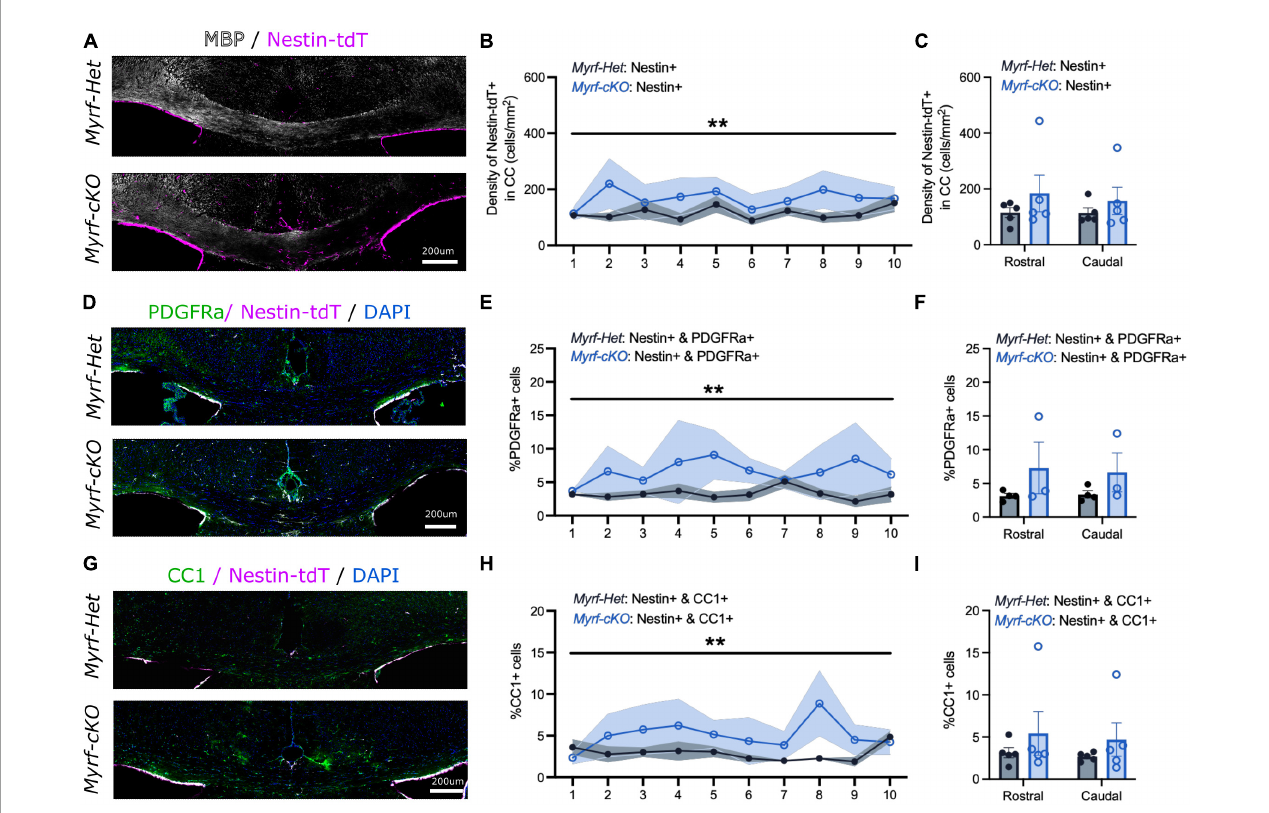
FIGURE4 The contribution of neural stem cell-derived oligodendrocytes (OLs) to remyelination remains elevated at 4 weeks of recovery when parenchymal oligodendrocyte progenitor cell differentiation is blocked. (A) Representative images of Myrf-Het;Nestin-tdT and Myrf-cKO;Nestin-tdT coronal brain sections immunostained for MBP (in white) and Nestin-tdT (magenta) after 4-week recovery (Cup6w + 4w). (B) Quantification of the densities of Nestin-tdT+ cells within the CC of Myrf-Het;Nestin-tdT and Myrf-cKO;Nestin-tdT coronal sections ( n = 5, lines and shading represent mean ± sem, ** p < 0.01, Two-way ANOVA). (C) Average densities of Nestin-tdT+ cells within the CC of Myrf-Het;Nestin-tdT and Myrf-cKO;Nestin-tdT rostral (sections 1–5) and caudal (sections 6–10) sections ( n = 5, error bars = sem, Two-way ANOVA). (D) Representative images of Myrf-Het;Nestin-tdT and Myrf-cKO;Nestin-tdT coronal brain sections immunostained for PDGFRa (in green) and Nestin-tdT (magenta) after 4-week recovery (Cup6w + 4w). (E) Quantification of the percentages of PDGFRa+ cells that were also Nestin-tdT+ in Myrf-Het;Nestin-tdT and Myrf-cKO;Nestin-tdT coronal sections ( n = 3–4, lines and shading represent mean ± sem, ** p < 0.01, Two-way ANOVA). (F) Average percentages of PDGFRa+ cells that were also Nestin-tdT+ in Myrf-Het;Nestin-tdT and Myrf-cKO;Nestin-tdT rostral (sections 1–5) and caudal (sections 6–10) sections ( n = 3–4, error bars = sem, Two-way ANOVA). (G) Representative images of Myrf-Het;Nestin-tdT and Myrf-cKO;Nestin-tdT coronal brain sections immunostained for CC1 (in green) and Nes-TdT (magenta) after 4-week recovery (Cup6w + 4w). (H) Quantification of the percentages of CC1+ cells that were also Nestin-tdT+ in Myrf-Het;Nestin-tdT and Myrf-cKO;Nestin-tdT coronal sections ( n = 5, lines and shading represent mean ± sem, ** p < 0.001, Two-way ANOVA). (I) Average percentages of CC1+ cells that were also Nestin-tdT+ in Myrf-Het;Nestin-tdT and Myrf-cKO;Nestin-tdT rostral (sections 1–5) and caudal (sections 6–10) sections ( n = 5, error bars = sem, Two-way